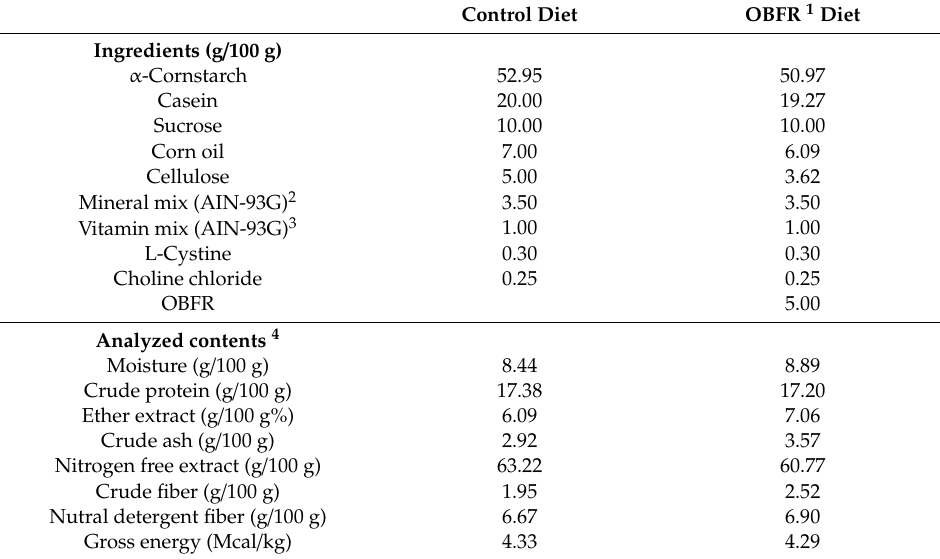
Table 1. Composition of experimental